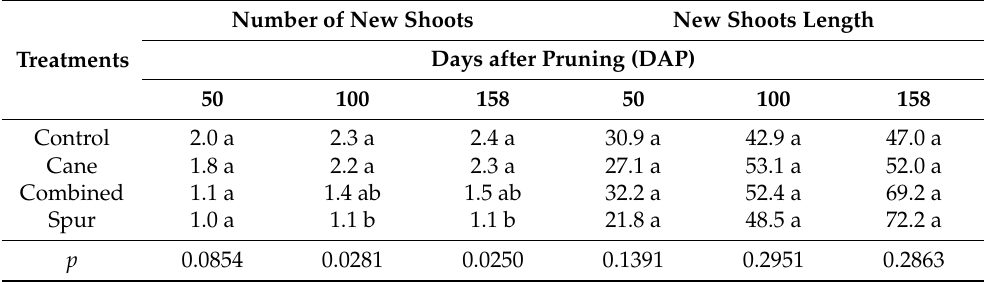
Table 1. Number of new cladodes and length (cm) along the season in response to different pruning